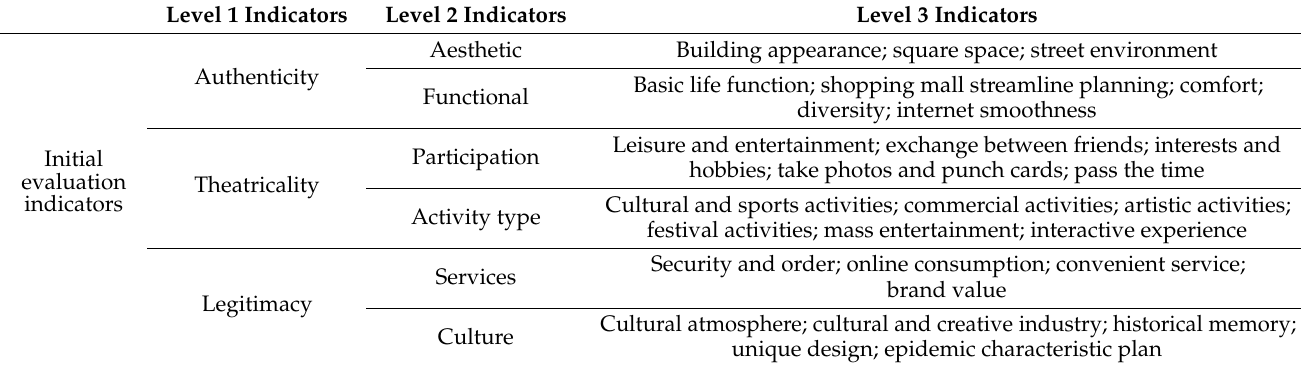
Table 1. Initial evaluation indicators.